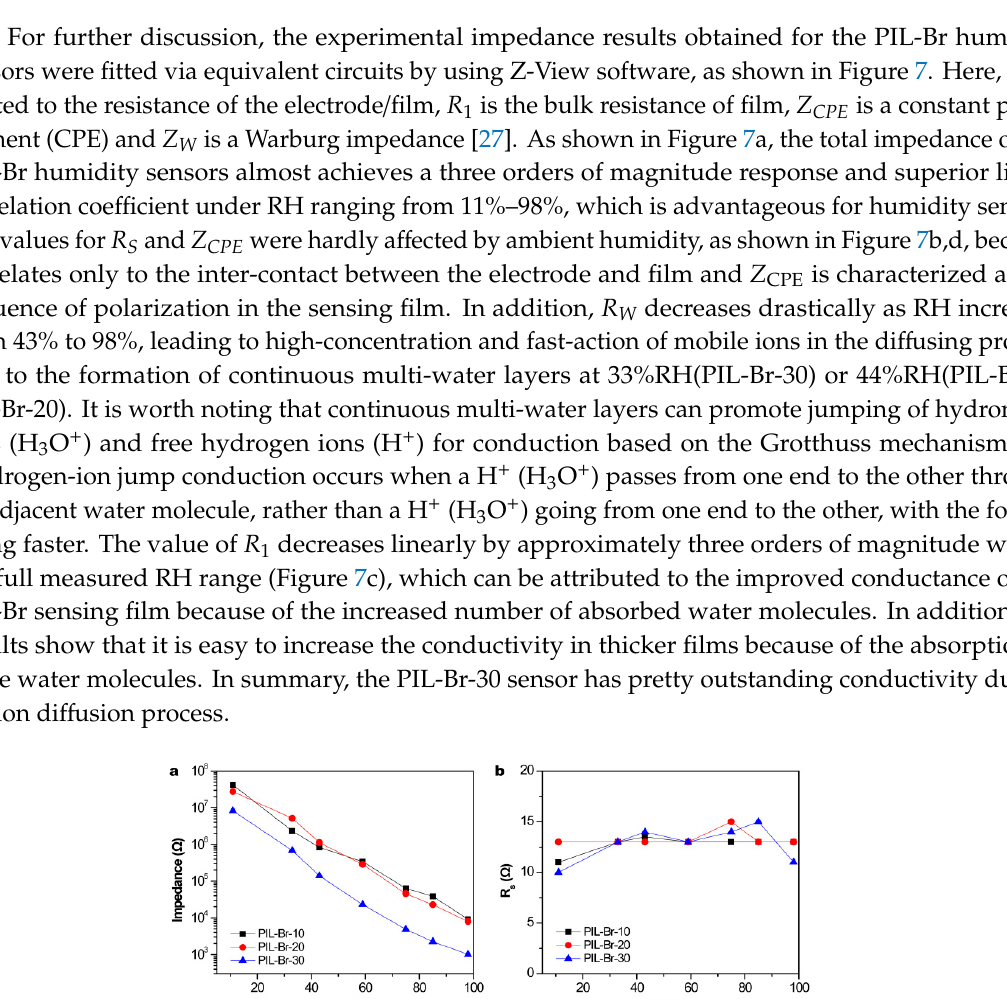
Figure 6. Response and recovery properties for PIL-Br humidity sensors with varying thickness.